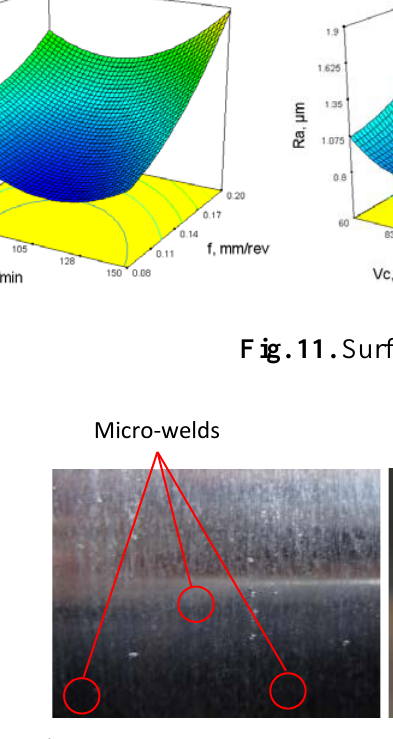
Fig. 12. Micro-weld on machined surface and Built-up edge on cutting